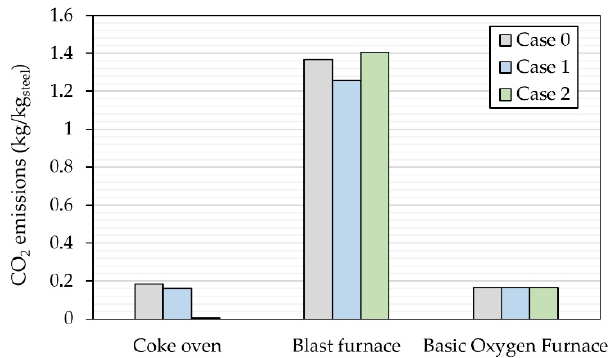
Figure 6. CO 2 emissions by process for each plant layout (i.e., Case 0–2).